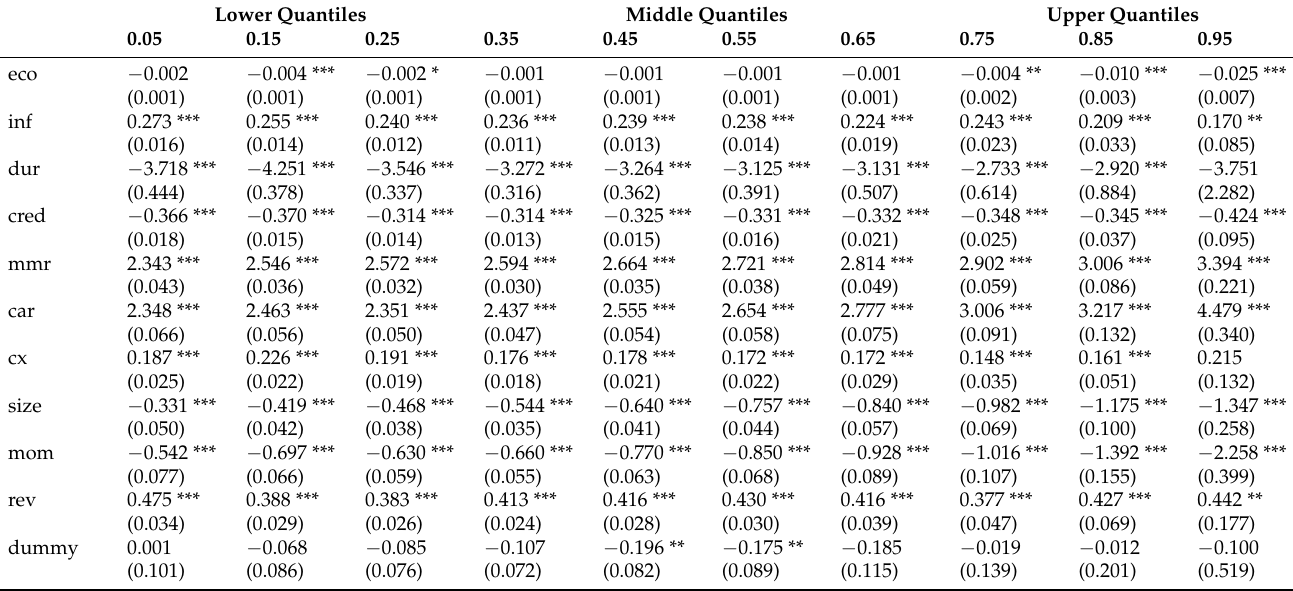
Table 4. Panel Conditional Quantile Regression—Economic Support Index.